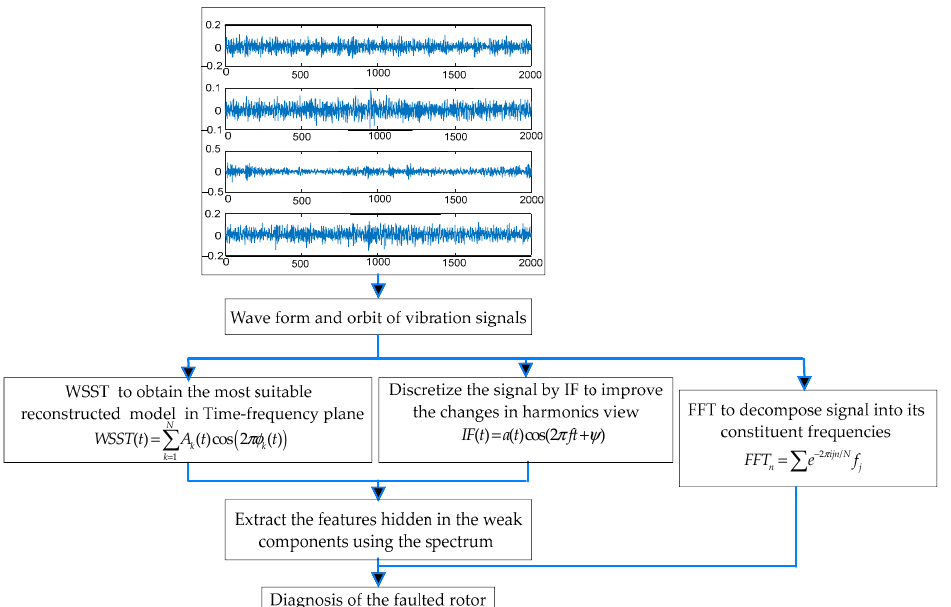
Figure 4. Flowchart of the proposed method of vibrational data processing.